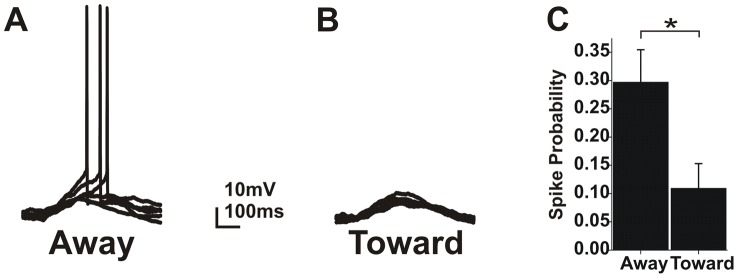
Directional summation increases excitability for centrifugal sequences.
A) 5 consecutive traces showing suprathreshold responses for the away activation sequence. B) Matched traces for activation moving toward the soma. C) A plot of the average spike probability in both directions for all experiments showing suprathreshold activity.